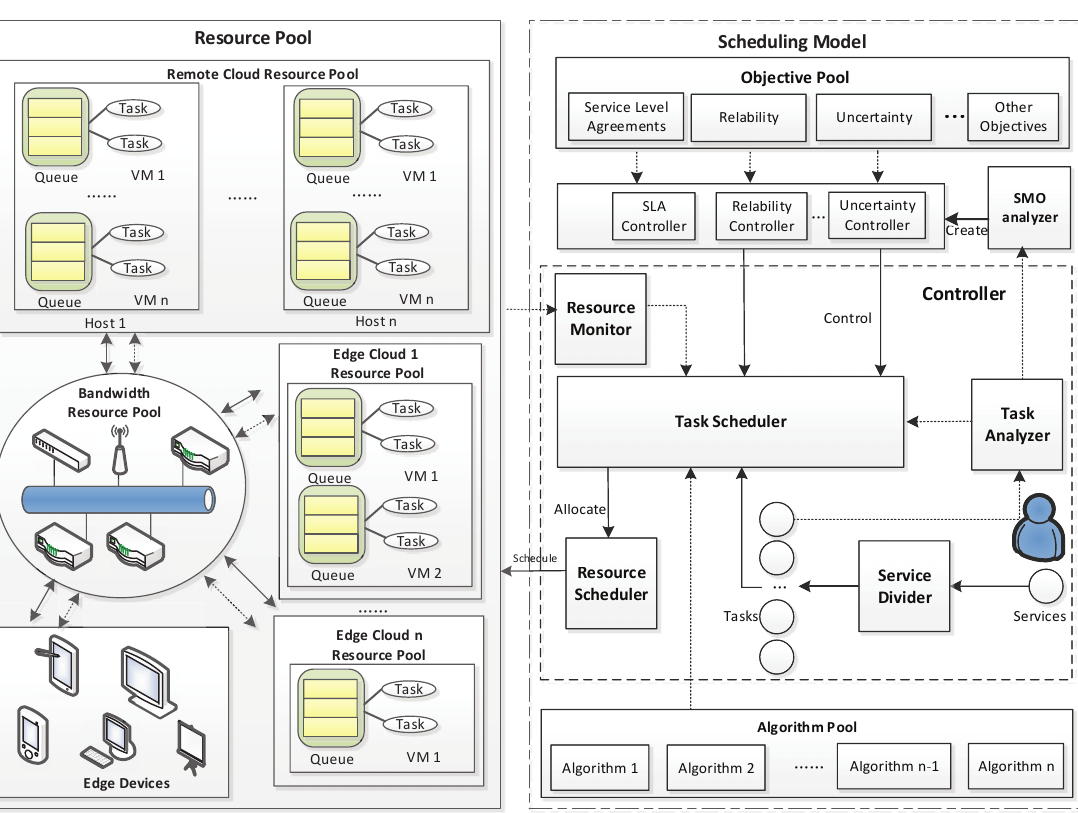
Figure 2. The overview of the scheduling